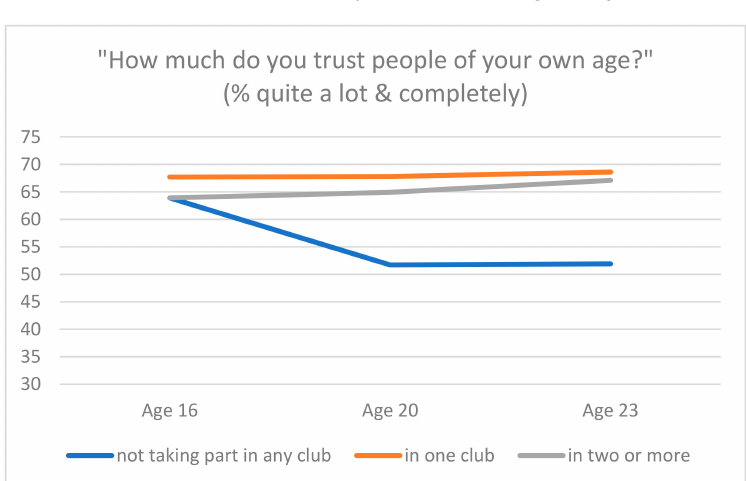
Figure 3. Generalized trust by tenure and living arrangement.